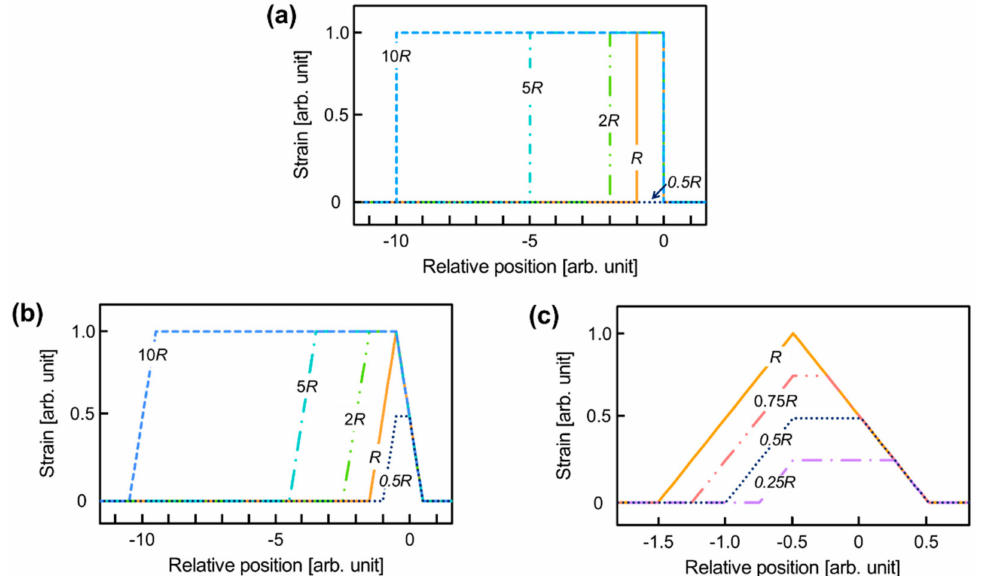
Figure 9. Deduced strain distributions directly obtained from the final power outputs of ( a ) standard BOCDR and ( b , c ) slope-assisted BOCDR. Note that the traces in ( a ) give the correct strain distributions. Reproduced with permission from [60]. Copyright (2016)